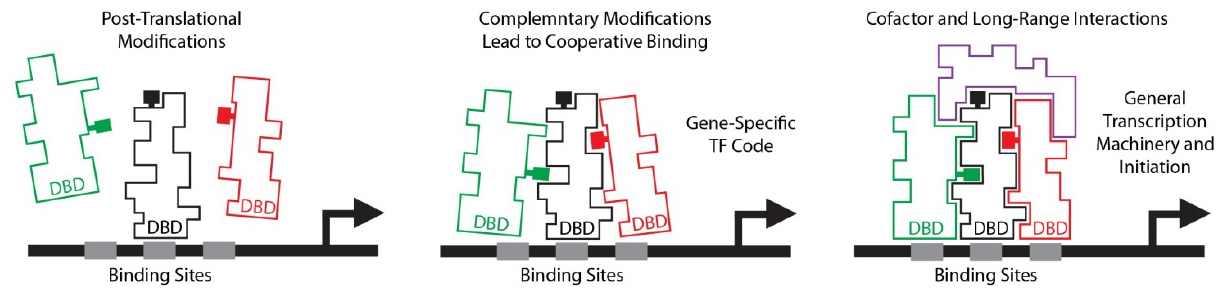
Figure 4. Transcription Factor Interactions. In this model promoters bind multiple transcription factors that must interact to form stable complexes that can stimulate gene expression. Post-translational modifications on the individual transcription factors (left) are the result of upstream signaling pathways, which promote interactions (middle), forming co-operative and synergistic binding and leading to interactions with co-activators and productive transcription initiation